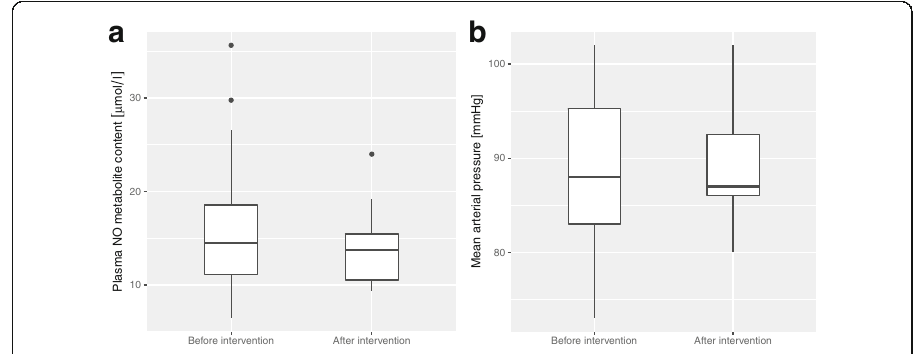
Fig. 1 Plasma nitric oxide metabolite content ( p = 0.66) ( a ) and mean arterial pressure ( p = 0.48) ( b ) before and after topical vasodilator application (intervention). Boxplots represent median, interquartile range, and range. NO nitric